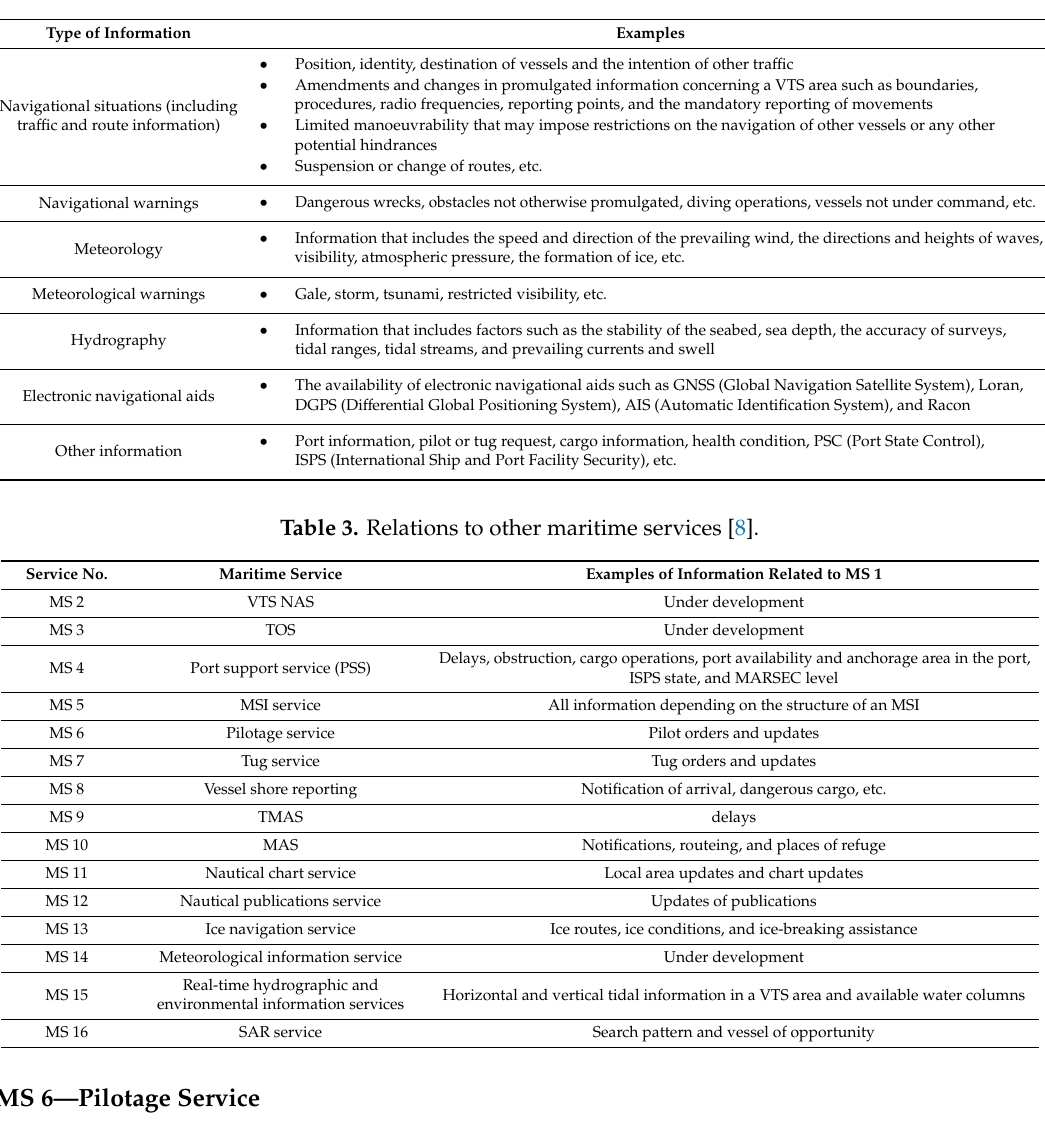
Table 2. Examples of the types of information that may be provided by a VTS to operate an INS (IALA Guideline 1089) [8,9].